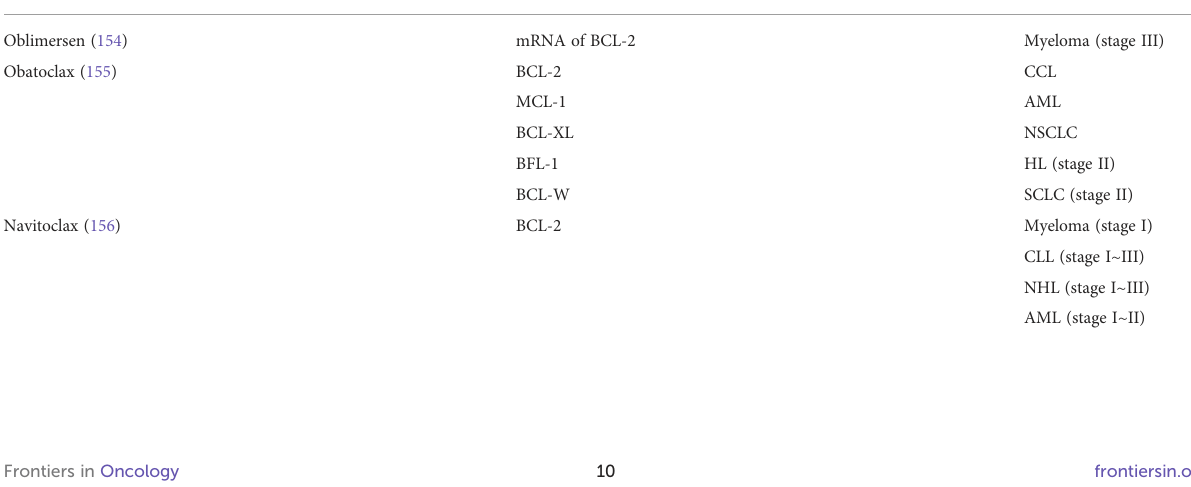
TABLE 2 Appellation, target, and clinical application of BCL-2 inhibitors.